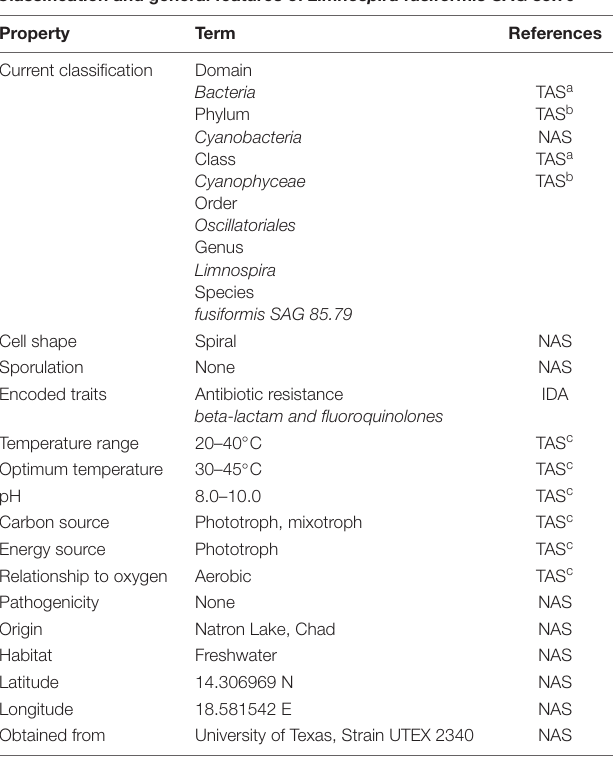
TABLE 1 | Classification and general features of L. fusiformis according to the MIGS standard (Field et al., 2008). Classification and general features of Limnospira fusiformis SAG 85.79